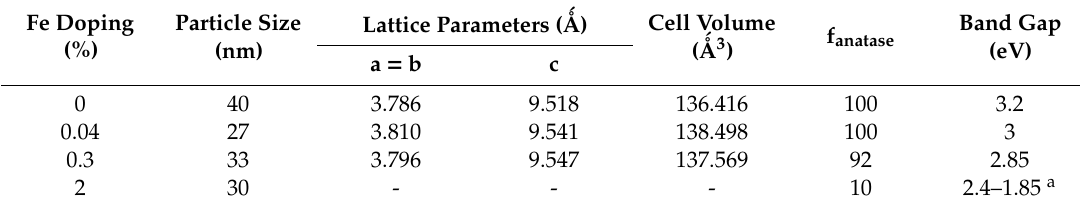
Figure 1. Effect of metal loading on structural characteristics of materials calcined at 973 K for 3 h. Table 1. Particle size, lattice parameters, cell volume, f anatase values and energy band gap of undoped and Fe doped TiO 2 materials. a Sub band gaps.